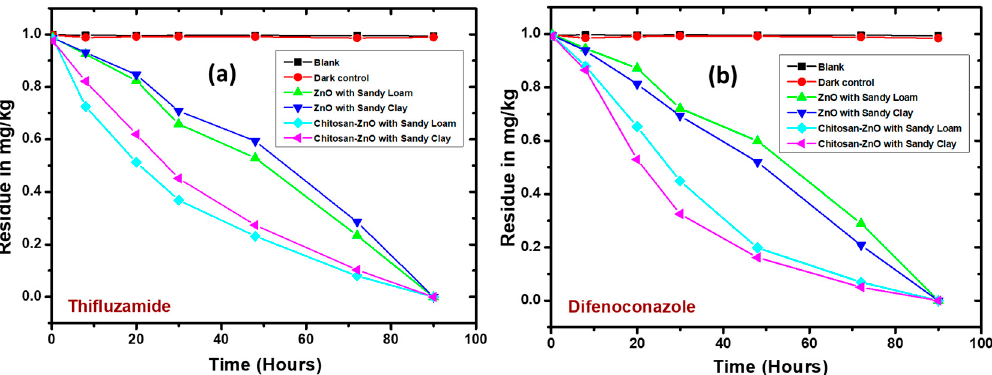
Figure 6. The dissipation curves of fungicide photocatalytic remediation of soils in sunlight by ( a ) thifluzamide and ( b ) difenoconazole.